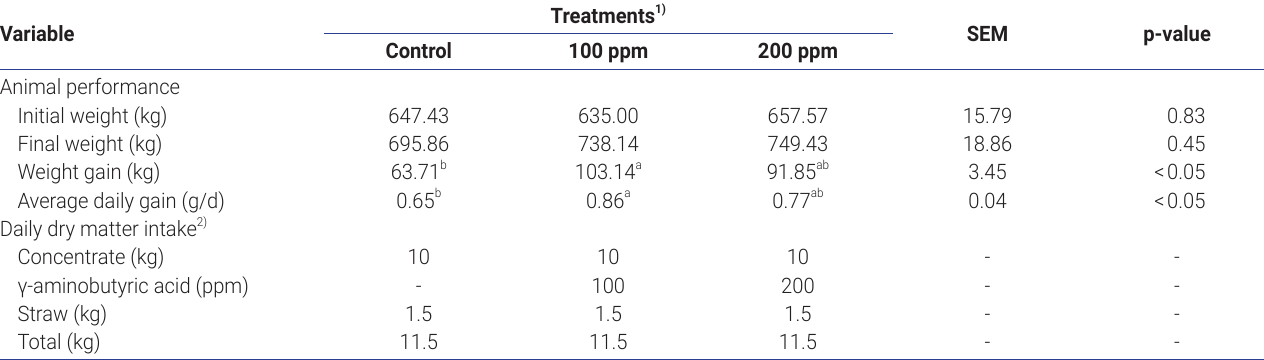
Table 1. Body weight gain and feed intake of Hanwoo steers fed with rumen protected γ-aminobutyric acid